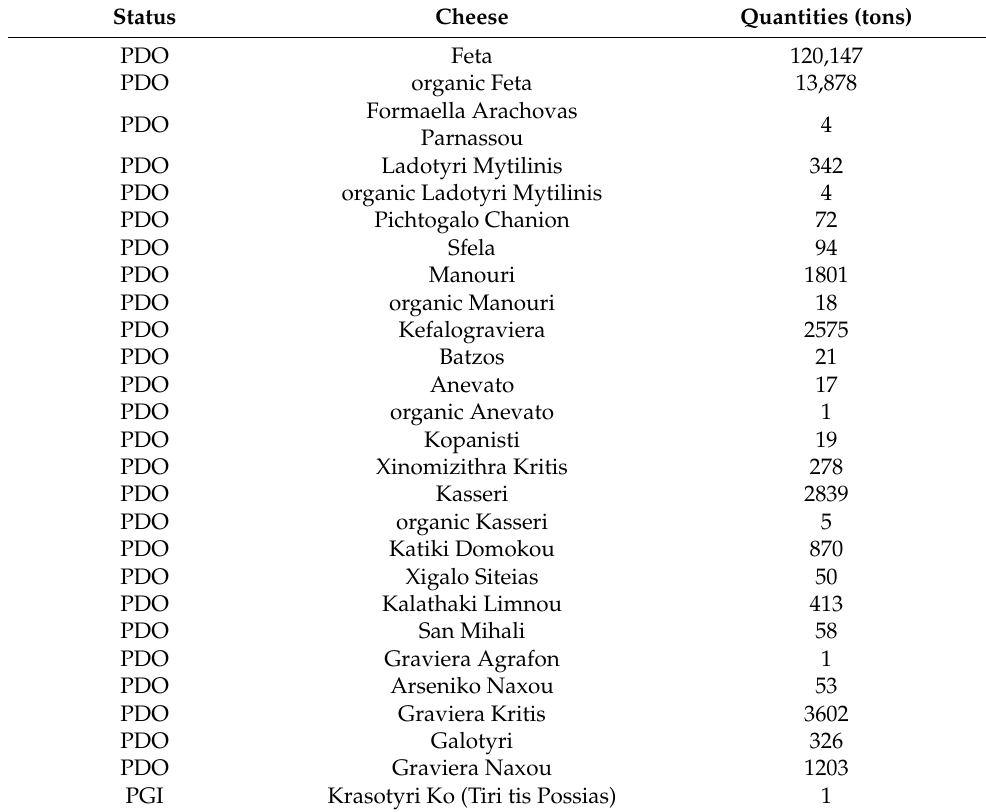
Table 1. Production quantities of protected designation of origin and protected geographical indica- tion cheeses (year